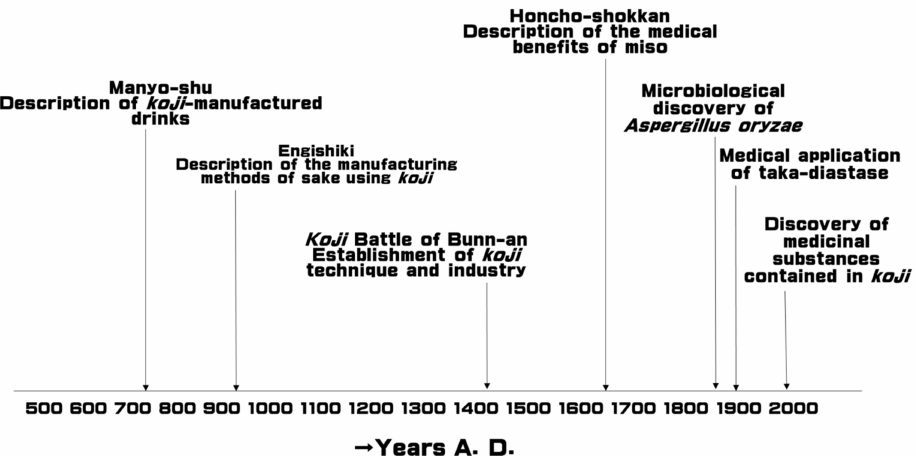
Figure 1. History of technologies and research on koji in